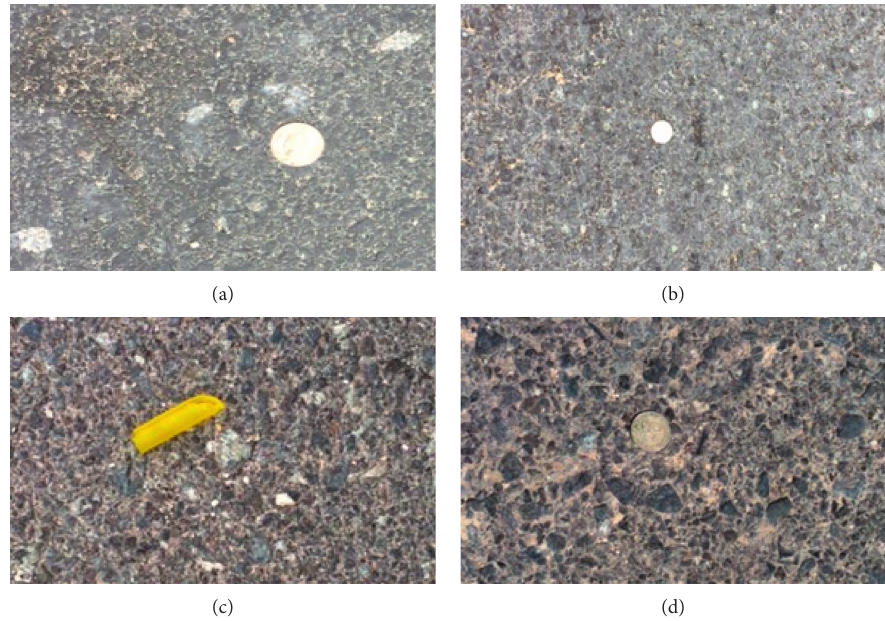
Figure 3: A photographic view of pavement surfaces. (a) G-Ring road (freshly paved layer). (b) Rawad Al Rashed road